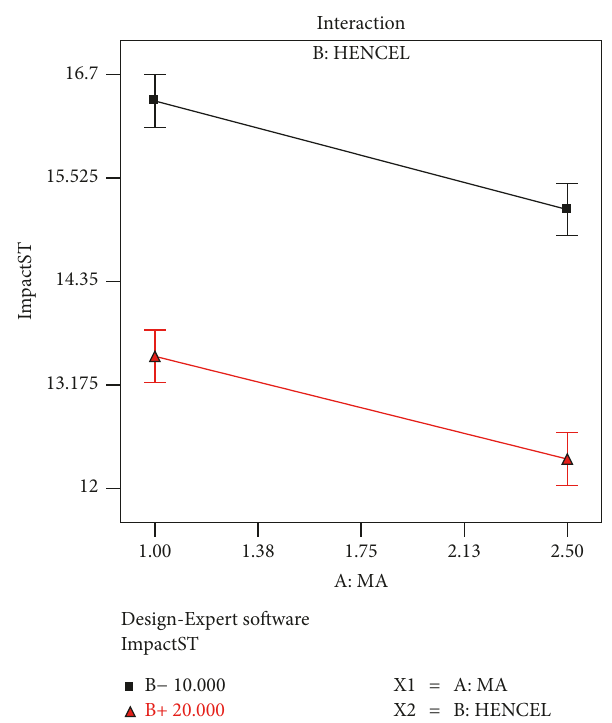
Figure 8: Interaction plots for Charpy impact